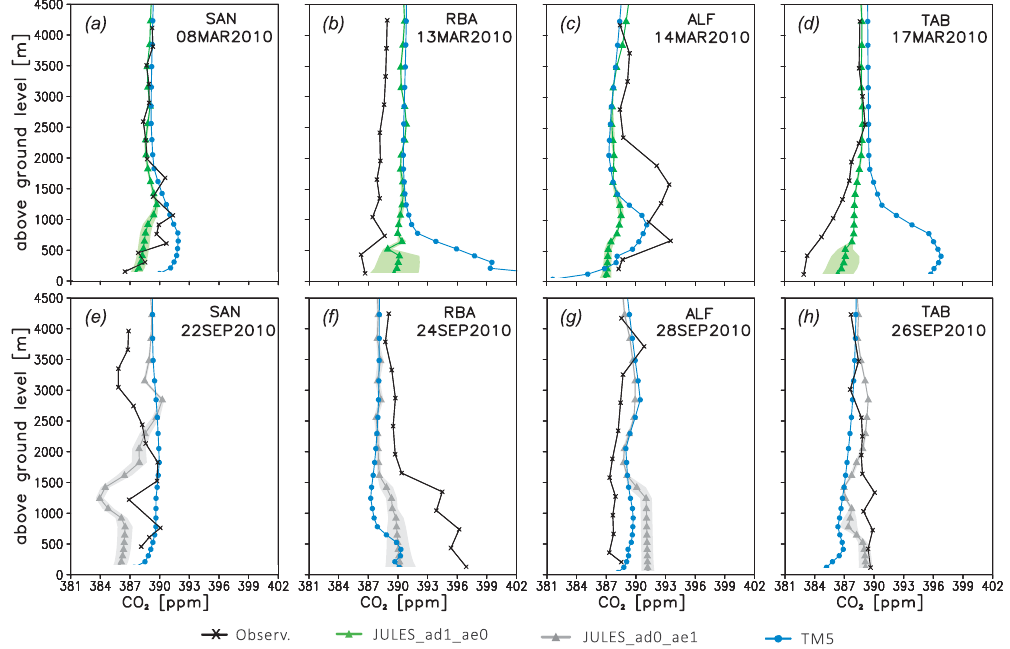
Fig. 9. Observed CO 2 vertical profiles (black lines), simulated with CarbonTracker model (blue lines) and simulated with JULES-CCATT- BRAMS (green and gray lines). The observations were collected at around 16:00UTC, and the simulated profiles correspond to 15:00UTC for CarbonTracker, because it has a temporal frequency of three hours, and a time average between 16:00 and 17:00UTC for JULES- CCATT-BRAMS (temporal frequency of one hour); green/gray shading represents the standard deviation of the time average. The title of each figure contains the respective locations and dates of the profiles, where SAN = Santar´em (54.95 ◦ W, 2.86 ◦ S), RBA = Rio Branco (67.62 ◦ W, 9.38 ◦ S), ALF = Alta Floresta (56.75 ◦ W, 8.80 ◦ S) and TAB = Tabatinga (70.06 ◦ W, 5.96 ◦